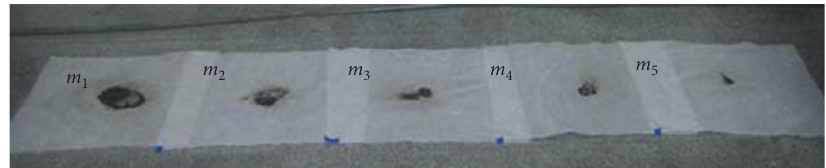
Figure 6: The lost particles collected at given time